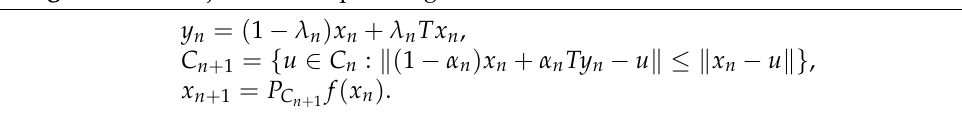
Algorithm 6: Projected fixed point